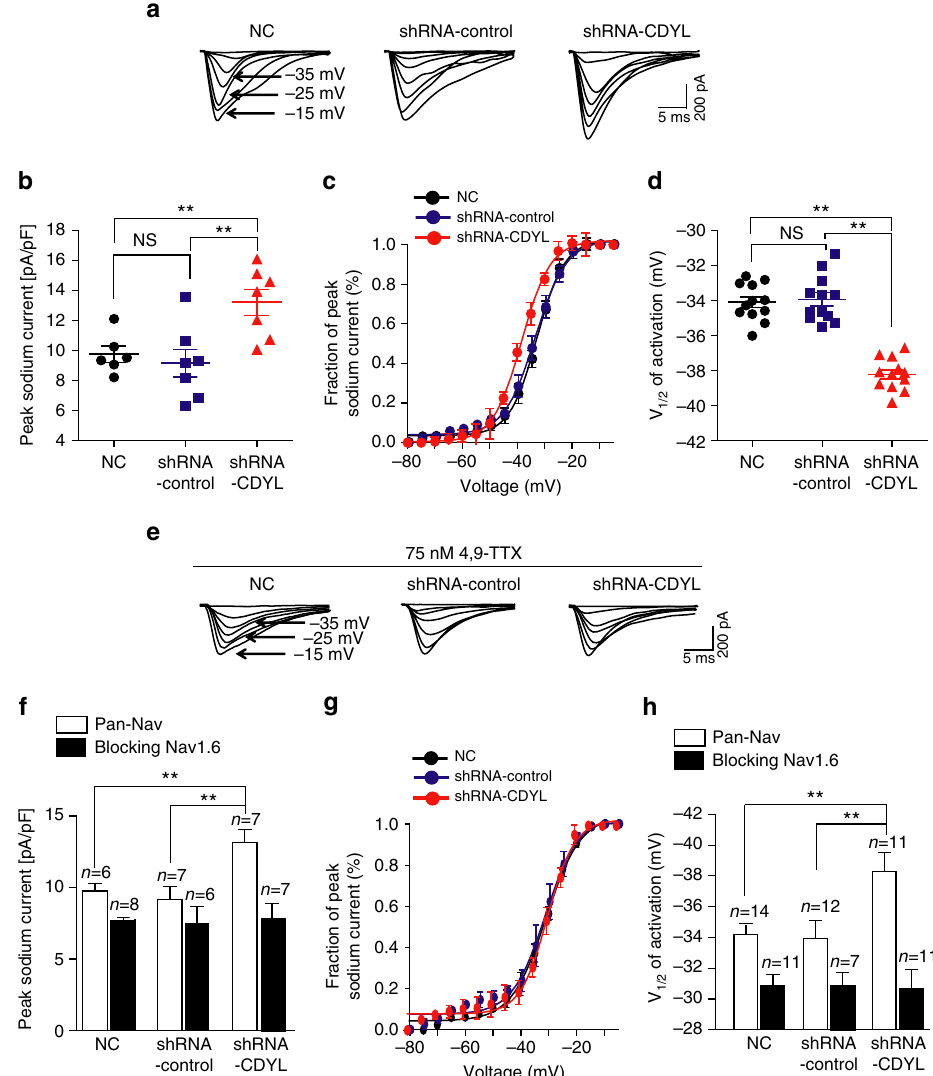
Fig. 7 Knockdown of CDYL enhanced Nav1.6-mediated current. a Representitive sodium current traces obtained from normal control (NC), nonsilencing- shRNA-infected and CDYL-shRNA-infected rat DG neurons. Sodium currents were evoked by step depolarization from soma. b – d Graphs showing the density of peak sodium currents, activation curves and half-activation values of sodium currents, respectively. ** p < 0.01, one-way ANOVA with Bonferroni ’ s multiple-comparison test. e Representitive sodium current traces in the presence of 75 nM of 4,9-TTX. f – h Graphs showing the density of peak sodium currents, activation curves and half-activation values of sodium currents, respectively, in the presence of 75 nM of 4,9-TTX. The above experiments were all performed with rat DG neurons. ** p < 0.01, one-way ANOVA with Bonferroni ’ s multiple-comparison test. Data were represented as mean ±